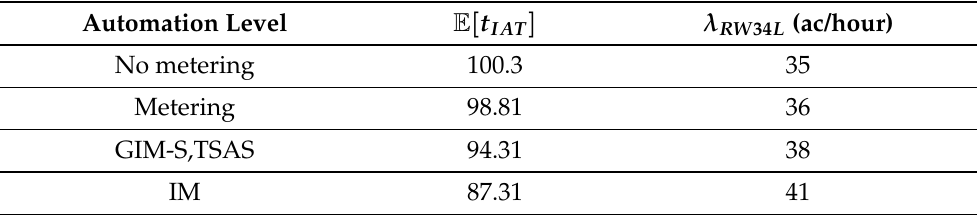
Figure 7. Estimated t min distribution at runway 34L during the peak period. Table 4. The maximum arrival rate λ RW 34 L under RECAT separation depending on the level of automation